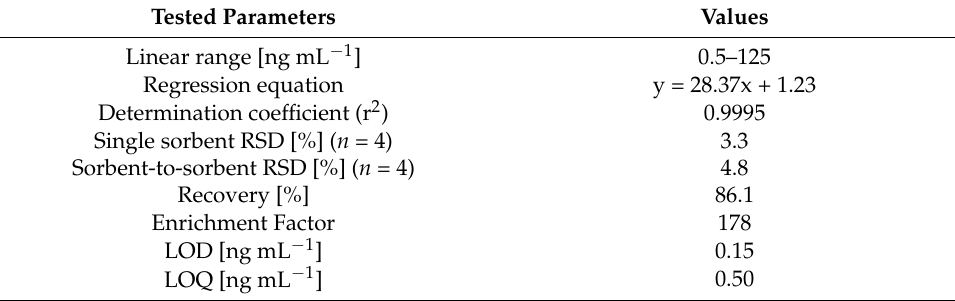
Table 2. The figures of merit obtained for the developed